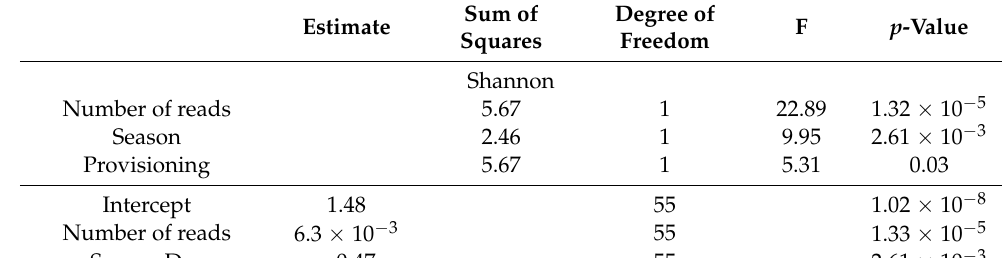
Table 2. Results for the selected LMM based on the Shannon index.